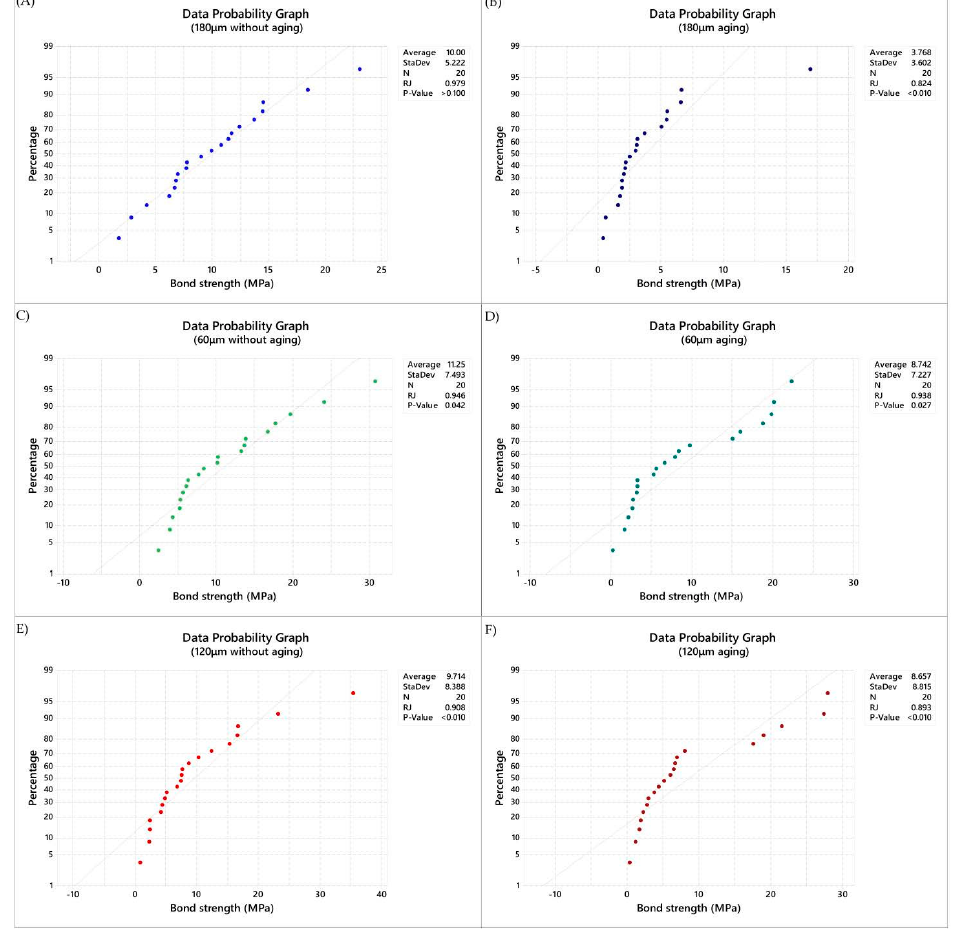
Figure 2. Normality data plot (Ryan–Joiner) applied in the present study. ( A ) Data probability graph in immediate tested samples with 180 μ m of cement layer thickness, ( B ) Data probability graph in aged samples with 180 μ m of cement layer thickness, ( C ) Data probability graph in immediate tested samples with 120 μ m of cement layer thickness, ( D ) Data probability graph in aged samples with 120 μ m of cement layer thickness, ( E ) Data probability graph in immediate tested samples with 60 μ m of cement layer thickness, ( F ) Data probability graph in aged samples with 60 μ m of cement layer thickness. The μ TBS results were statistically analyzed by Kruskal–Wallis and MINITAB Macro Dunn’s tests ( α = 0.05) for both groups of samples: immediately tested and tested after aging simulation. This macro performs multiple comparisons in a nonparametric setting.